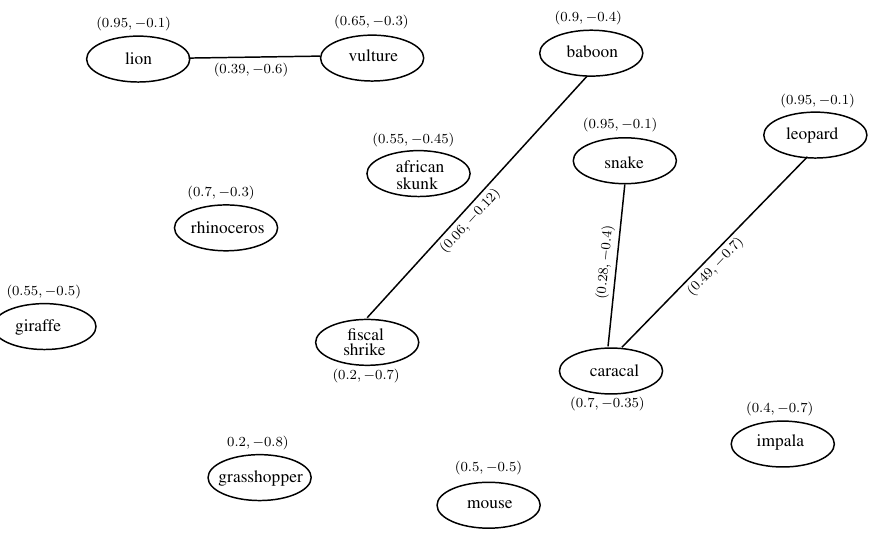
Figure 2.4: Bipolar fuzzy competition graph Figure 4. Bipolar fuzzy competition graph.